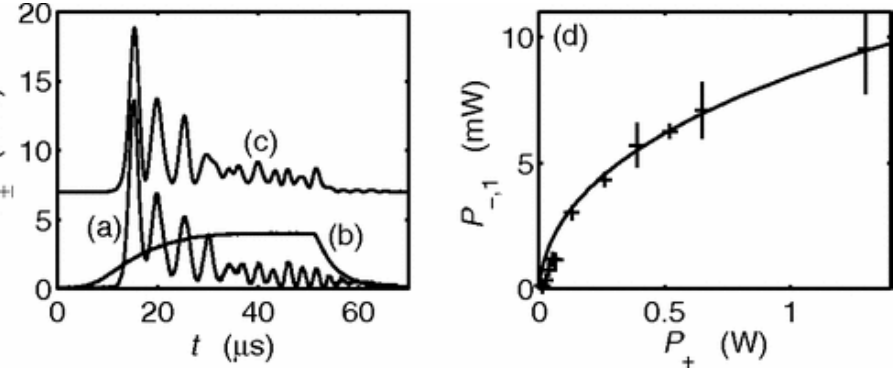
Figure 11. ( a ) Measured time evolution of the reverse power P − . The pump laser power is P + = 4 W. The cavity is operated at high finesse. The atom number is N = 1.5 × 10 6 and the laser wavelength is λ = 797.3 nm. Curve ( b ) marks the time evolution of the recorded pump laser power scaled down by 1000. Curve ( c ) shows (offset by 7 mW) a numerical simulation of the reverse power. To account for the finite switch-on time of the pump laser power, its experimentally recorded time evolution is plugged into the simulations, where we assume that the pump laser frequency is fixed and resonant to a cavity mode. ( d ) Measured and calculated (solid line) height P − ,1 of the first peak as a function of pump power P + . Here N = 2.4 × 10 6 and λ = 796.1 nm . Reprinted with permission from ref. [39]. Copyright 2007 American Physical Society.